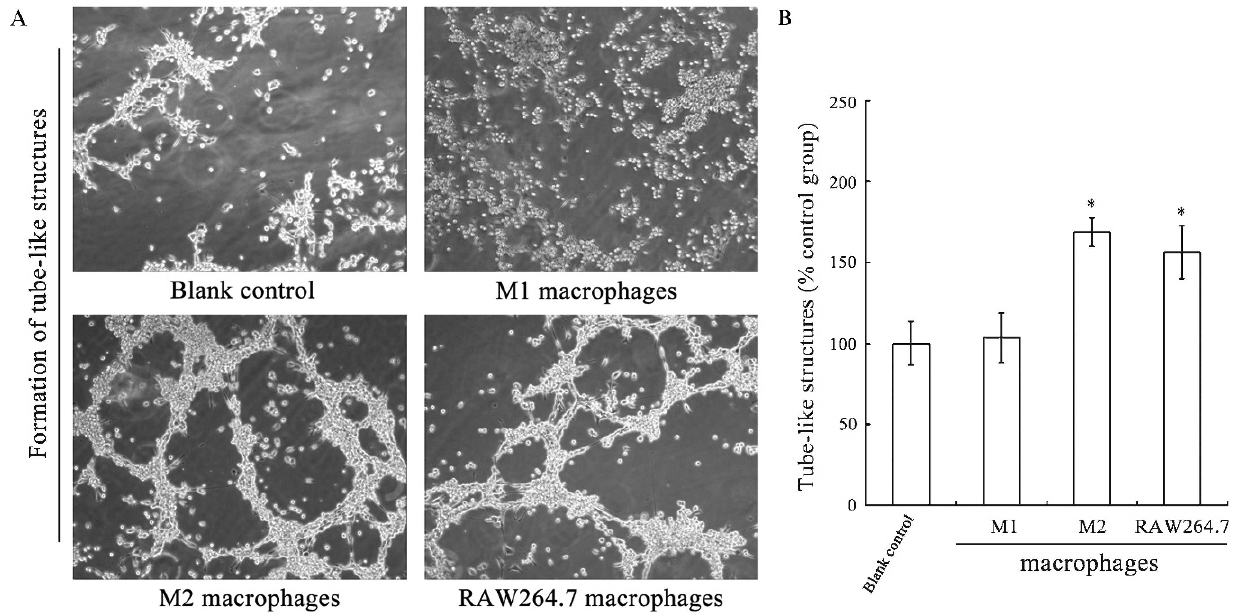
Figure 4 - Tumor-induced lymphangiogenesis stimulated by activated macrophages. (A) LECs were seeded in a 24-well plate pre-coated with Matrigel and maintained with media collected from LLC cells treated with activated macrophage-conditioned medium for 24 h. Capillary-like structures in the absence or presence of M1, M2 or RAW264.7 macrophages were determined 24 h later (200 6 magnification). (B) Comparison of the tube-like structures formed by LECs following exposure to macrophages with different activated phenotypes. The data shown represent three experiments. * p , 0.05 compared to the